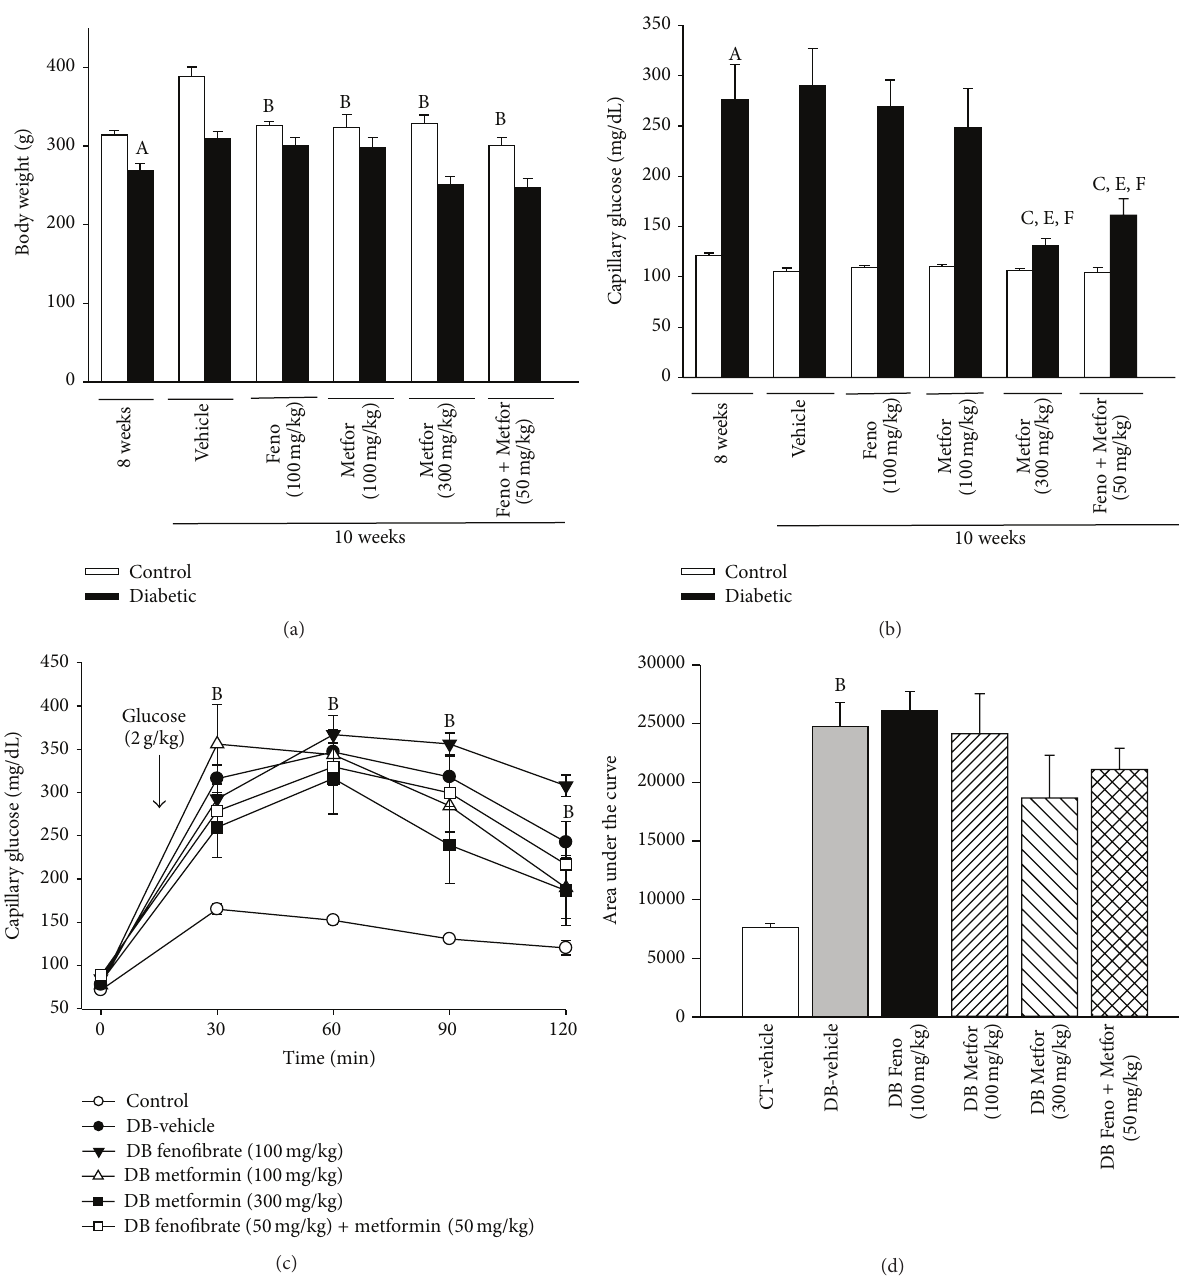
expression to control values. In CTI/R treatments did not modify the PPAR 𝛼 expression. Even though no statistical difference was found in DBSH-rats, a clear tendency of increased PPAR 𝛼 expression is observed in fenofibrate- and metformin- (100 and 300 mg/kg) treated rats (Figures 5(a) and 5(b)). groups compared to control